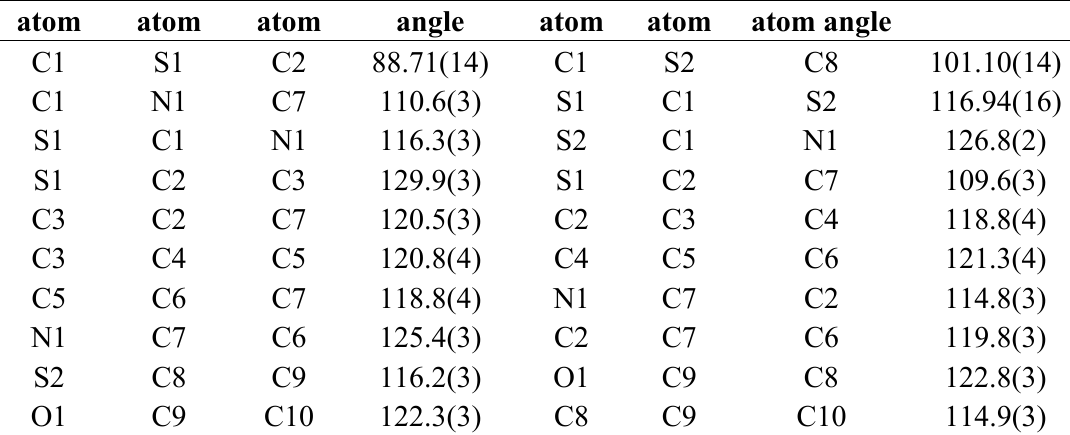
o ) for compound 5